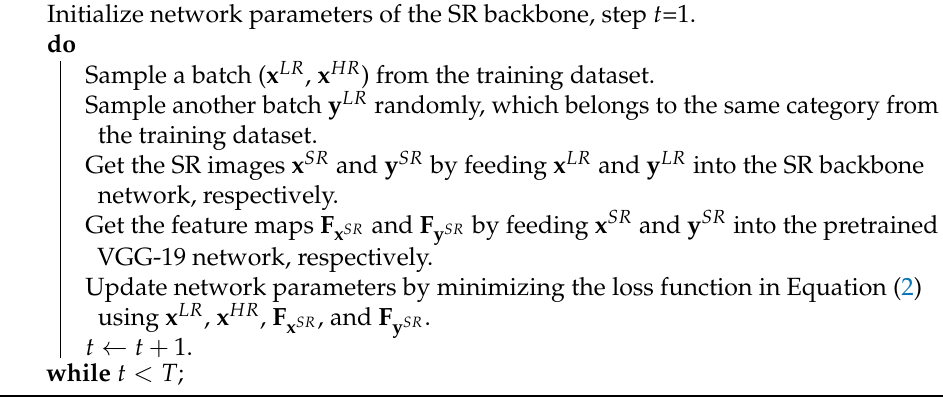
Figure 1. Process flow of the proposed method. Algorithm 1: Semantic SR via